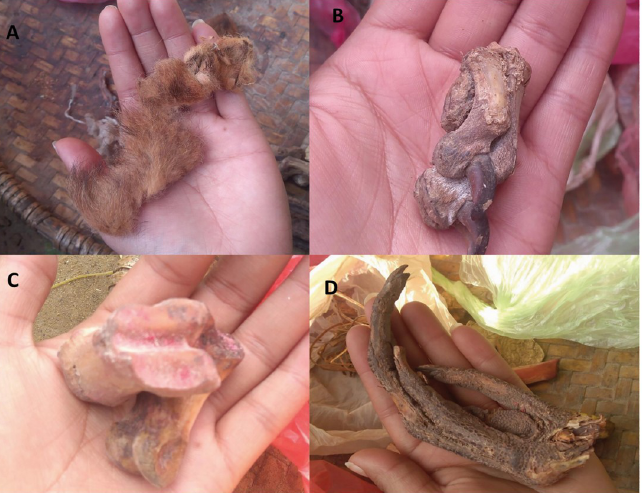
Fig 5. Parts of animals used by local ethnic groups for the treatment of different diseases: A- Skin of Tiger (paste of dry skin and hair is prescribed in mental illness) B- Dry meat of Wild boar (the soup of dry meat (leg) is provided to relief the patient suffering from epilepsy) C- Bone of Leopard (the soup of the bone or paste is considered as aphrodisiac in nature). D- Leg of Lesser adjutant (The paste of claws of stork is applied on the place of snake bite).